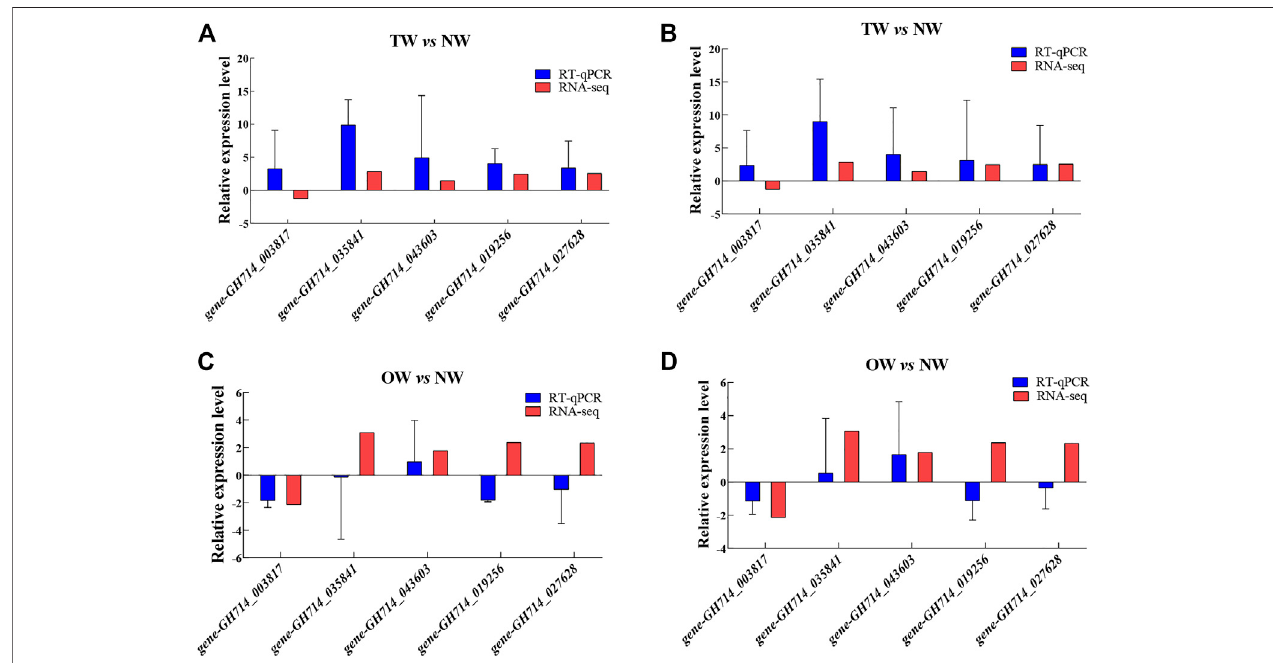
FIGURE6 | Relative expression of fi ve genesin TW vs. NW and OW vs. NW. Expression levels were determined by RT-qPCR using the 40S gene (A and C) or the Ubiquitin gene (B and D) as the internal control for normalization. Error bars indicate standard deviation of three biological replicates.